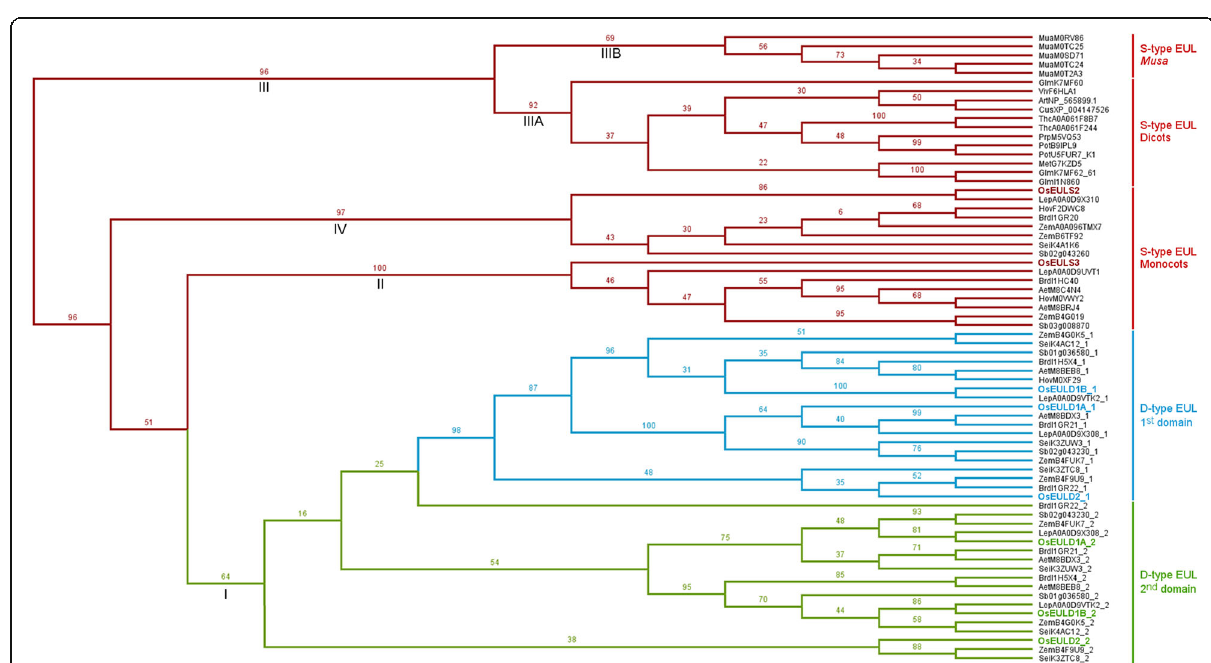
Fig. 8 Phylogenetic tree for all EUL domains retrieved from 9 monocot and 8 dicot species. EUL domains are annotated as S-type ( red ) or D-type EUL domains. The D-type domains are subdivided in domain 1 (N-terminal EUL domain) ( blue ) and domain 2 (C-terminal EUL domain) ( green ). Branch labels show bootstrapping